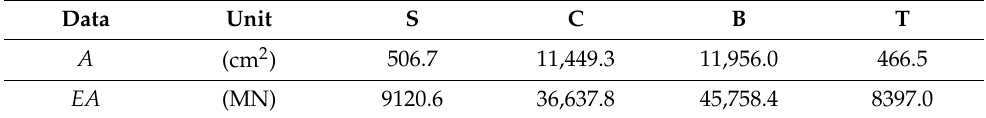
Table 1. Characteristics of the concreted cable before and after strengthening.